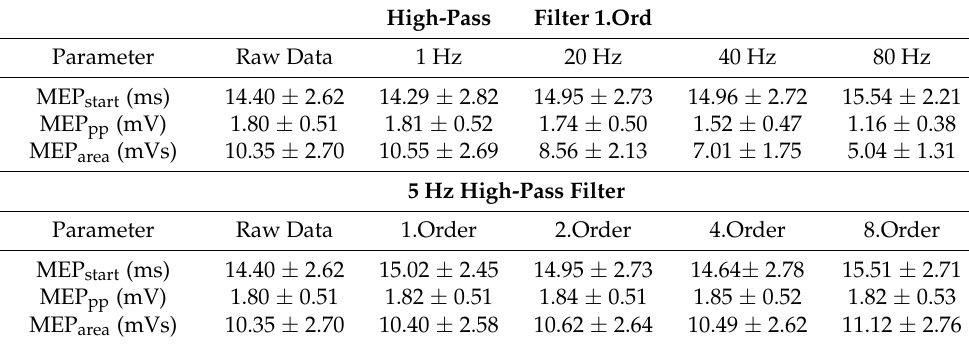
Table 2. MEP parameters of the ECR muscle are presented. Raw data (MEP raw ) were used as a reference value. The filter parameters vary in the cut-off frequency of the Butterworth HPF were chosen, while the order of the filter was kept constant at 1st-order (High-Pass Filter 1.Ord). MEP parameters (5 Hz High-Pass Filter) were shown against filter properties at different filter orders, while the cut-off frequency of the high-pass was set to 5 Hz. Values are the differences which were averaged over all subjects and presented as the mean ± standard deviation (SD). High-Pass Filter 1.Ord Parameter Raw Data 1